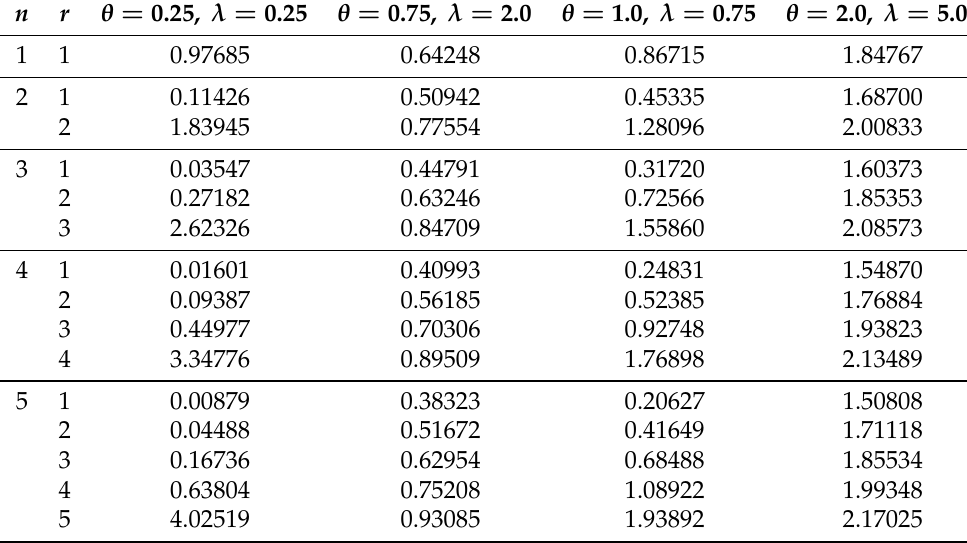
Table 1. Means of order statistics for the GB( θ , λ )